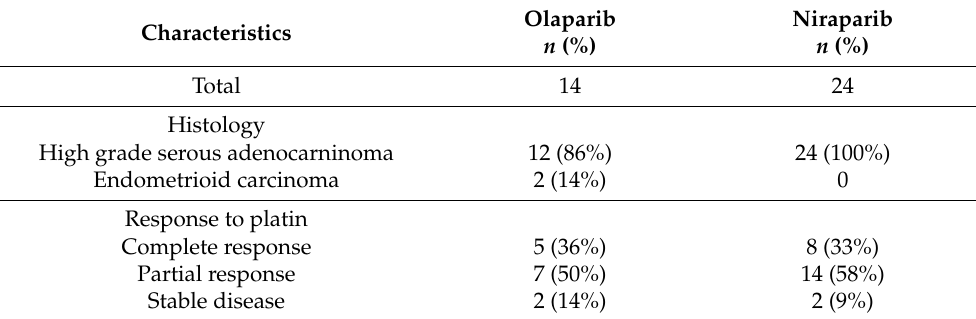
Table 4. Clinical and pathologic characteristics of ovarian cancer